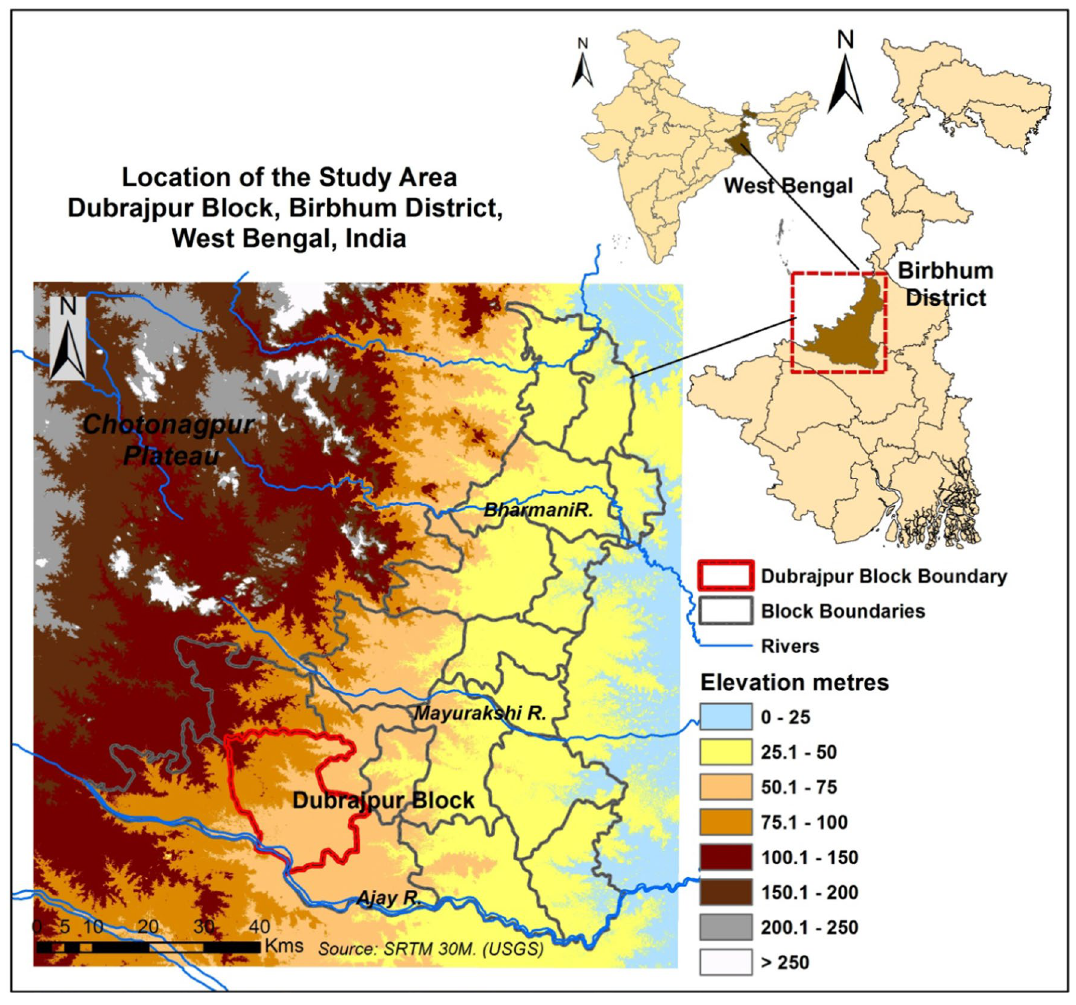
Fig. 1 Location of the Study